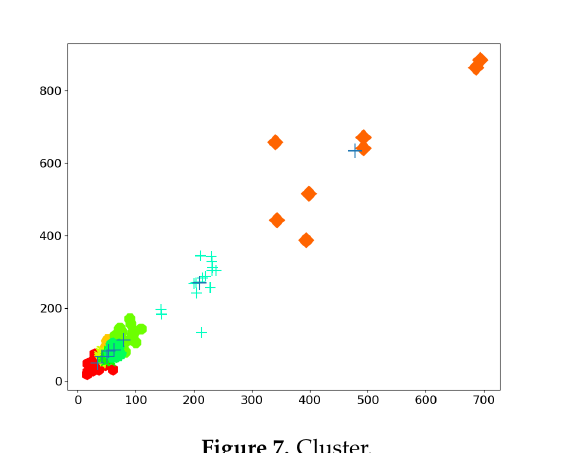
Figure 7. Cluster. Table 3. The width and height of anchor boxes.